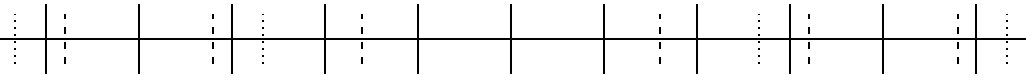
k + , dashed markers 2